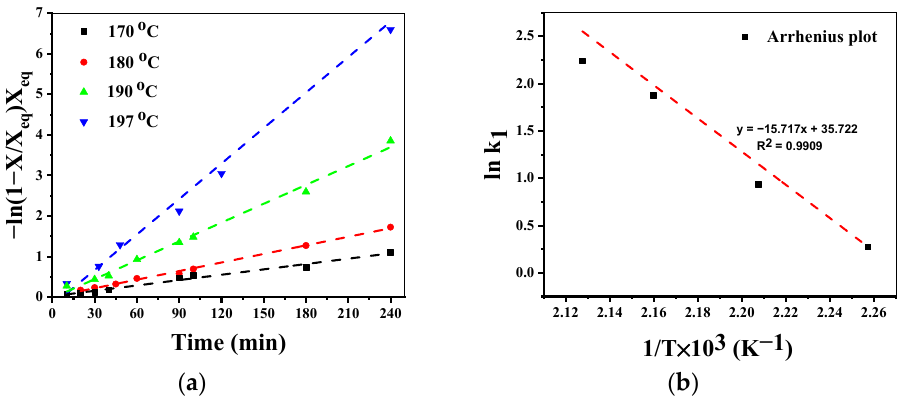
Figure 6. Kinetic model fitting of PET glycolysis in homogenous system ( a ) effect of temperature on reaction rate ( b ) Arrhenius plot for the homogenous system.